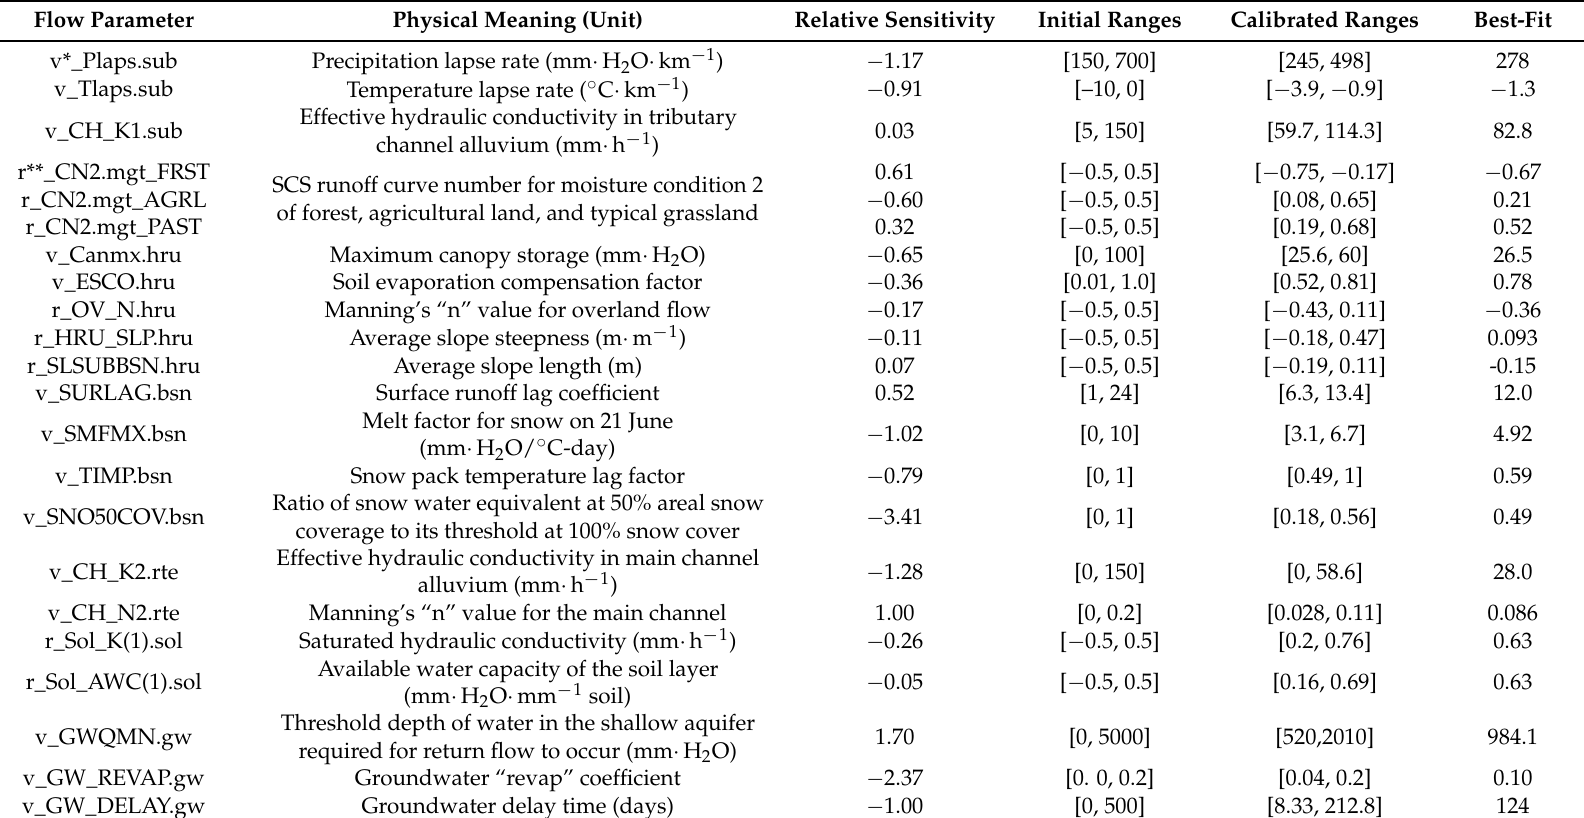
Table 2. Physical meanings, sensitivity, initial and calibrated ranges of flow